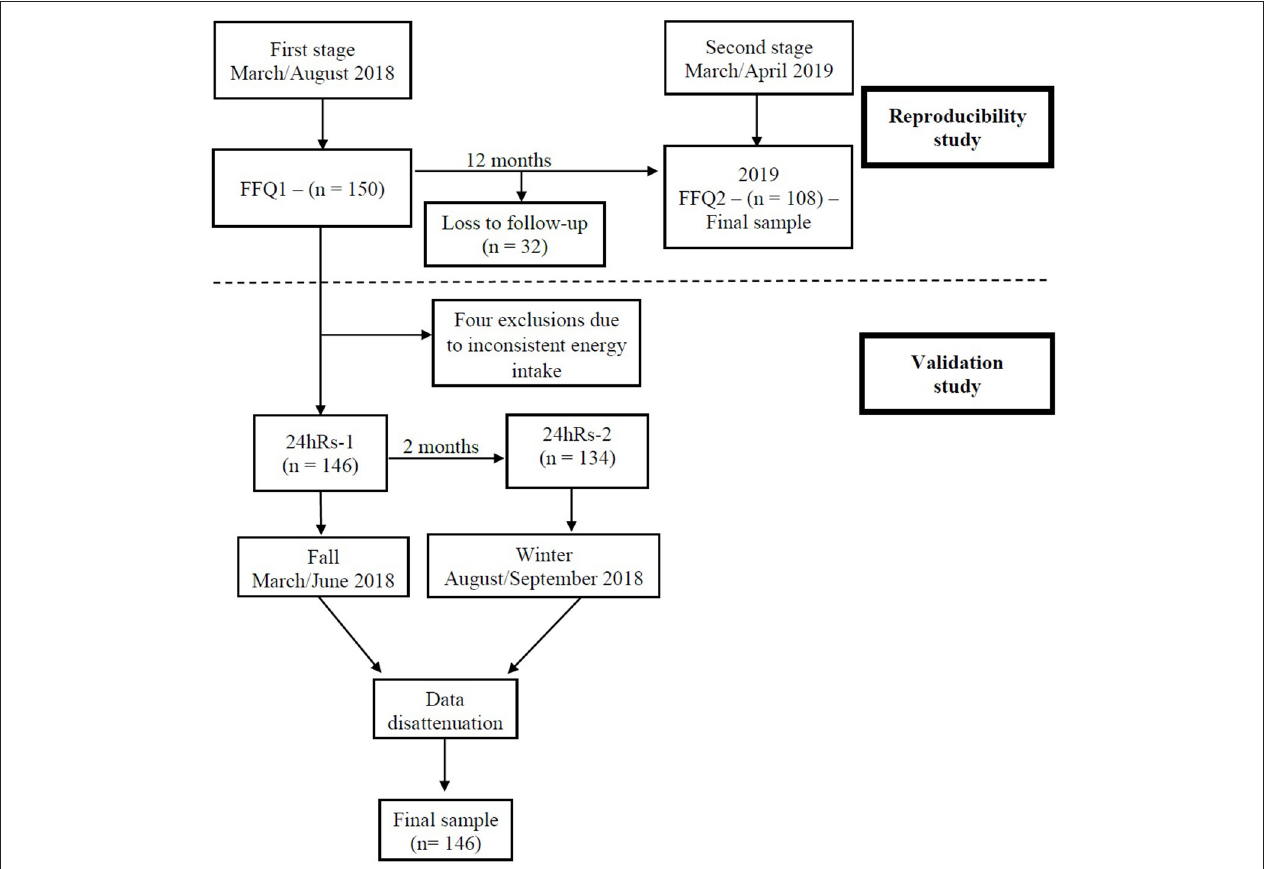
FIGURE 1 | Study flowchart of the validity and reproducibility of the online food frequency questionnaire. CUME Project,